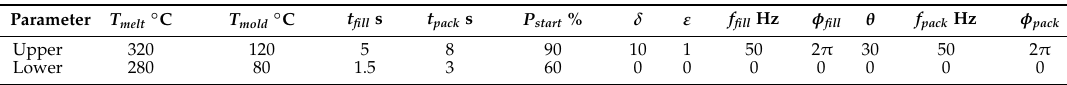
Table 9. The boundary values of the design parameters.